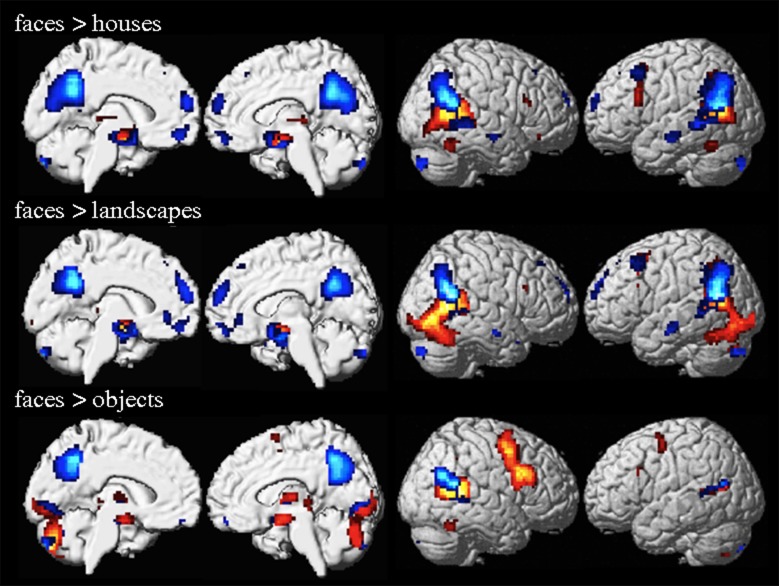
Group 80x1 analysis activation maps for the different contrasts.Activation maps for the contrasts a) f > h, b) f > l, and c) f > o, thresholded at p<0.05 FWE at voxel level, are rendered on the lateral and medial surface of the SPM standard brain template. Areas which are driven by enhanced activation and decreased deactivation to faces are shown in red/yellow and blue/light blue, respectively.